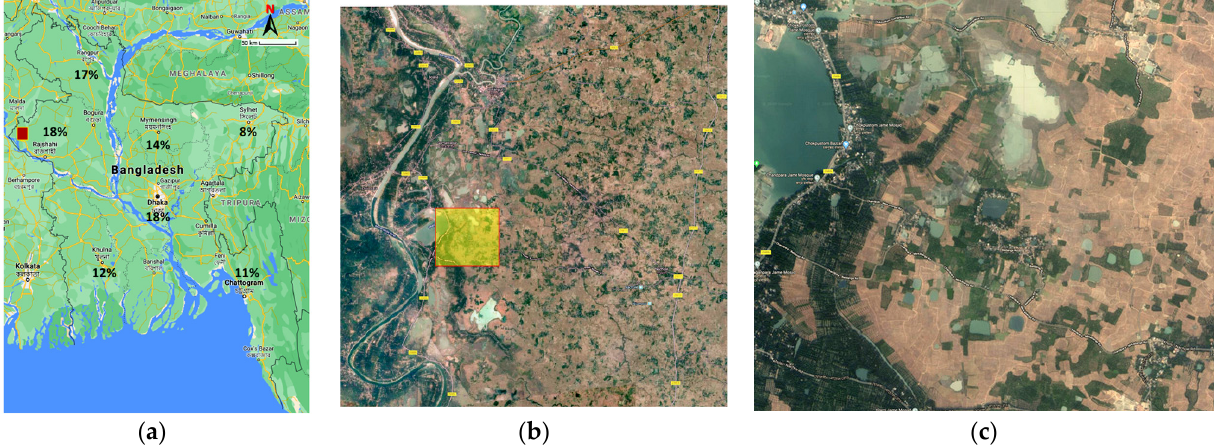
Figure 2. Boro production and illustrative implementation of AWD in Bangladesh; ( a ) Total Boro cultivation (2015–2016), ( b ) Portion of the medium Boro production zone focused for AWD implementation as marked in Figure 2a by the red box, and ( c ) closer view of an IoT-based AWD system.